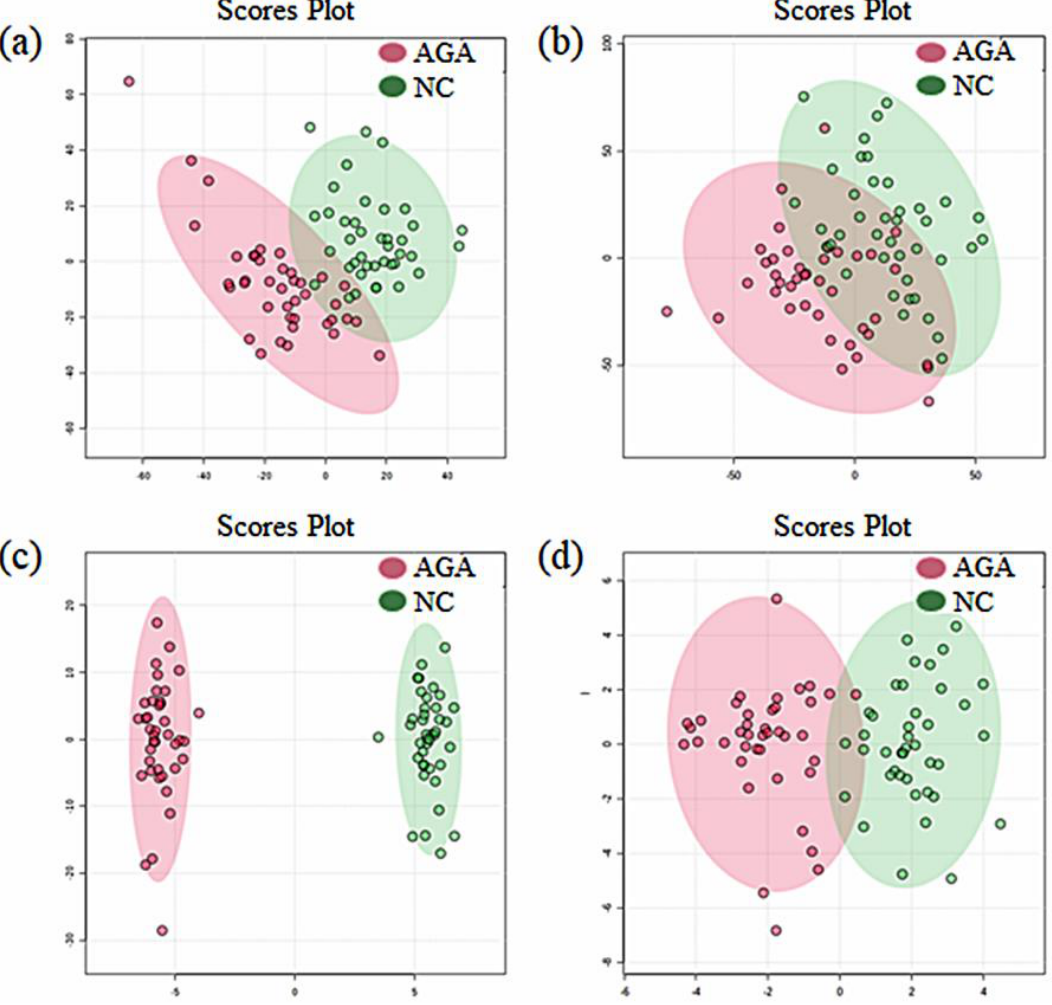
Figure 1. Scores plots obtained by PLS-DA and OPLS-DA with healthy controls labeled using red circles and patients with hair loss labeled using green circles. ( a ) PLS-DA in positive mode, ( b ) PLS-DA in negative mode, ( c ) OPLS-DA in positive mode, and ( d ) OPLS-DA in negative mode. PLS-DA, partial least squares discriminant analysis; OPLS-DA, orthogonal partial least squares discriminant analysis; AGA, androgenic alopecia patients; and NC, normal controls.